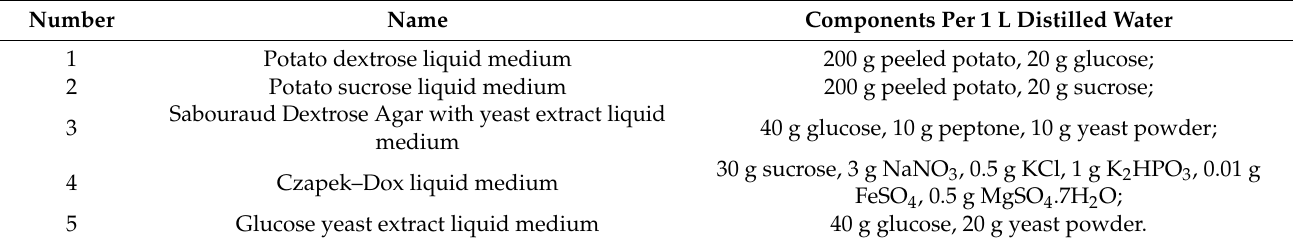
Table 1. Culture medium